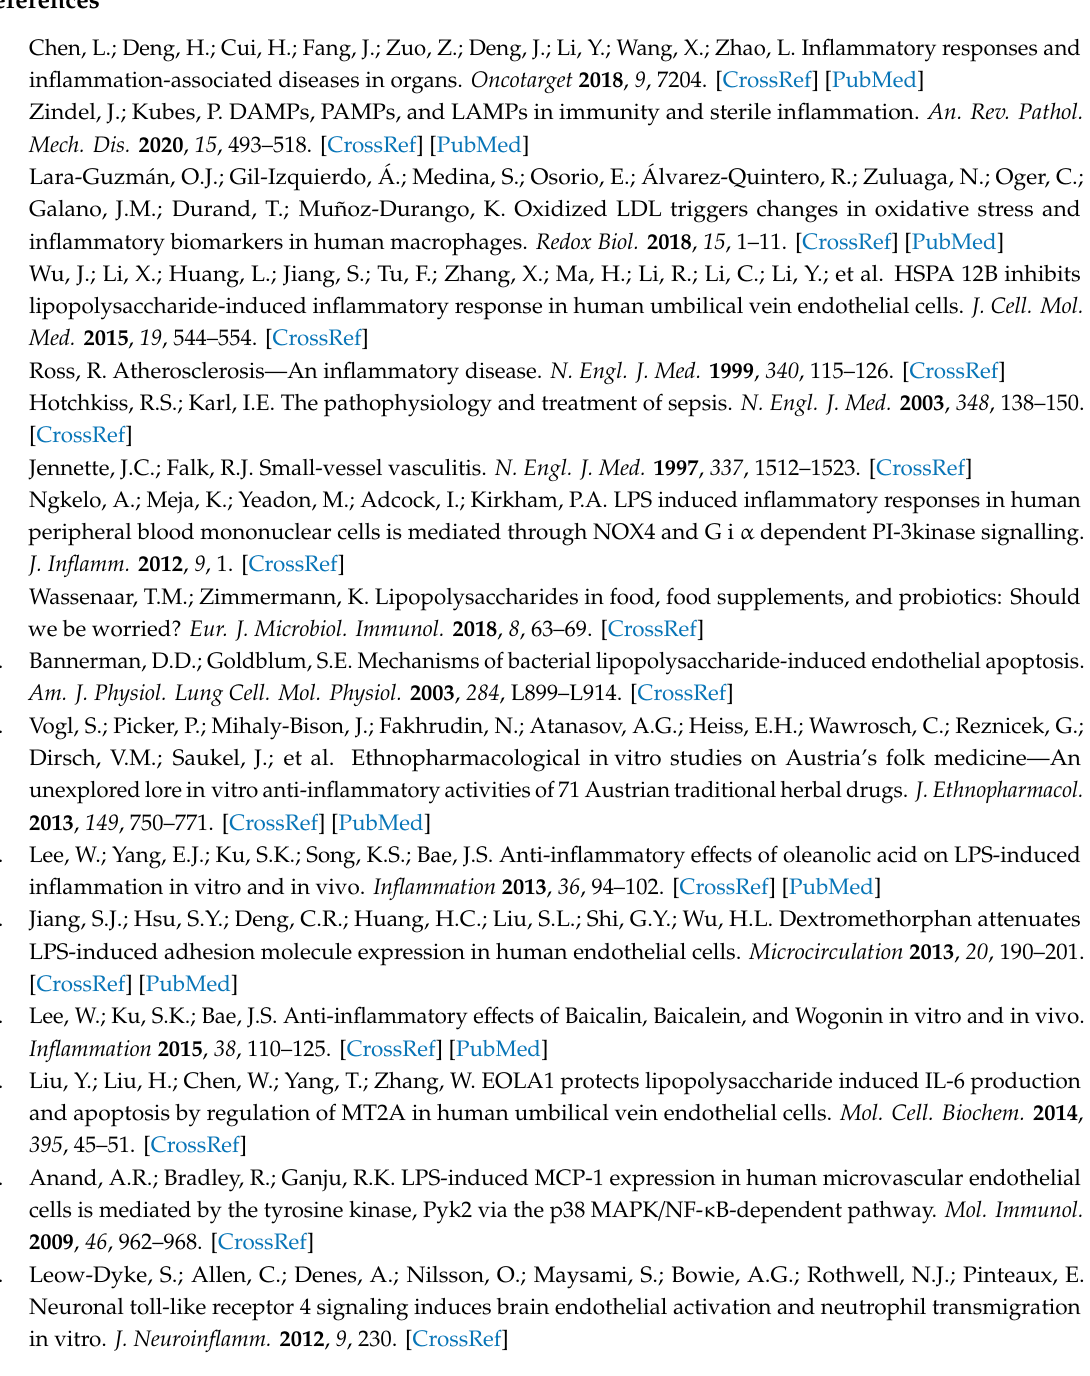
Confocal image of endothelial cells on basal plane stained for nucleus (blue), actin filament (red), and VE-cadherin (green, bottom), scale bar = 50 µ m. (E) VE-cadherin expression area to endothelial cell area ratio (n = 3 × 3, n.s: not